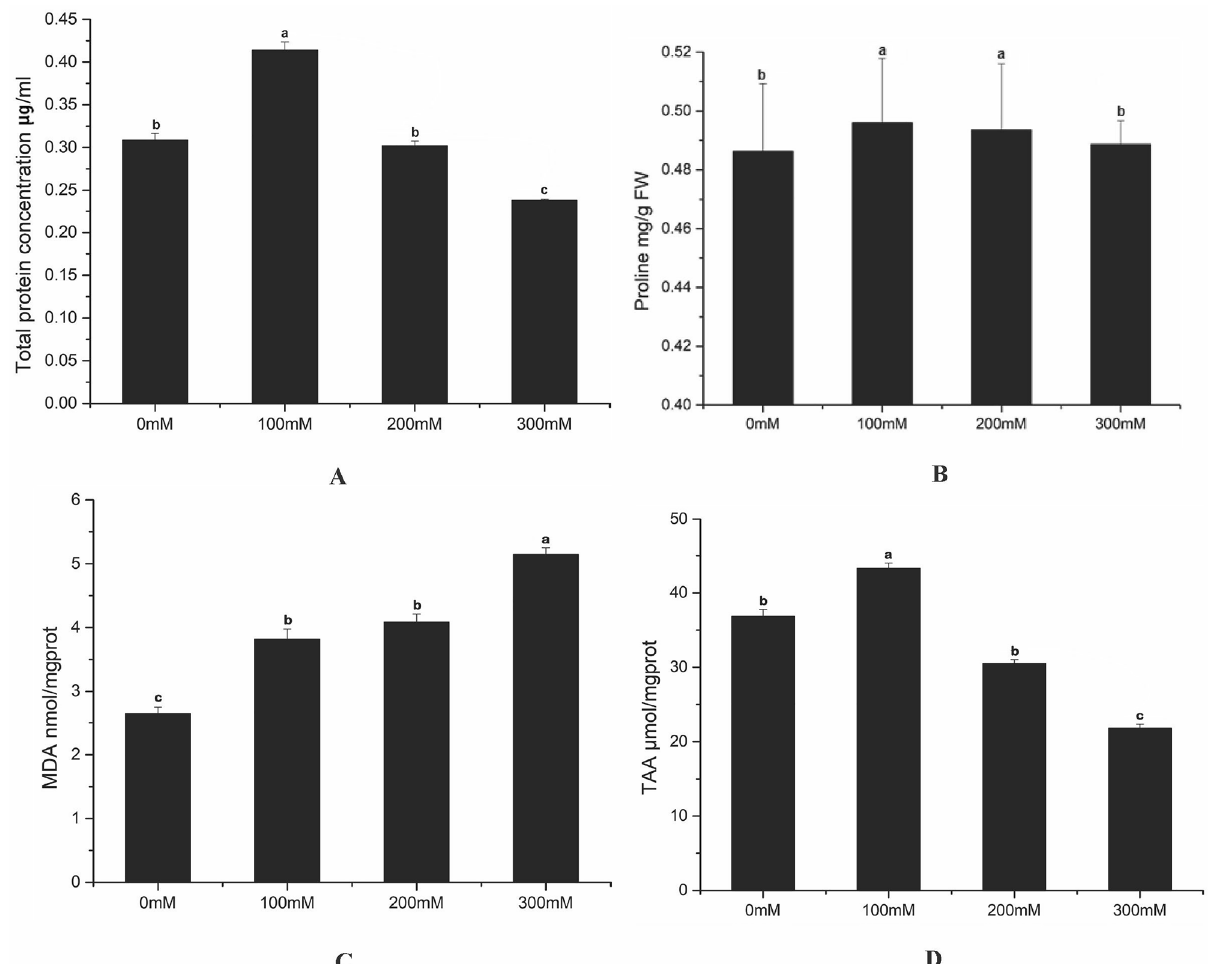
Figure 2. Changes in soluble proteins ( A ), proline ( B ), MDA ( C ), and TAA ( D ) under different concentrations of NaCl (The bars were standard deviation (SD) in